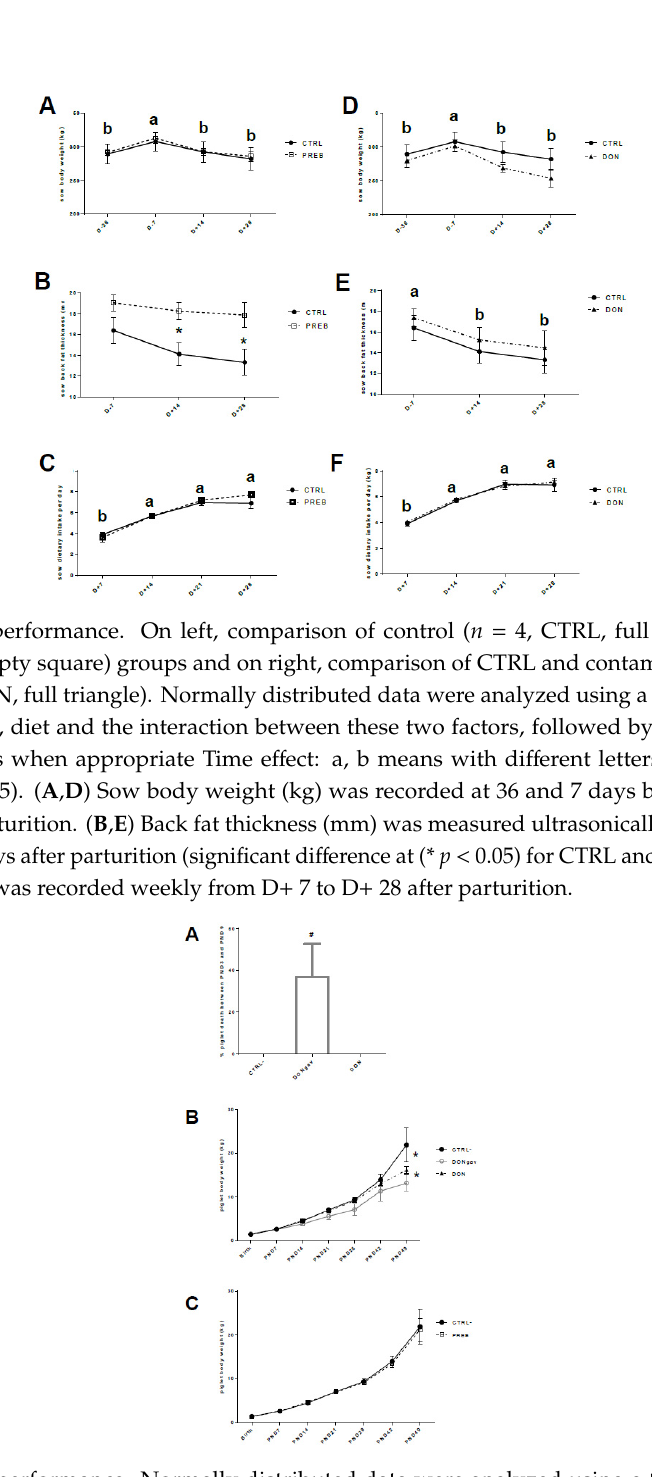
Figure 3. Piglet performance. Normally distributed data were analyzed using a two-way ANOVA performing time, diet and the interaction between these two factors, followed by Tukey’s multiple comparison tests when appropriate ( A ) Piglet death proportion (% of the litter size) from PND3 to PND9 after force-fed gavage with DON (DONgav) compared to control (CTRL-) and maternal supplementation with DON (DON). # means di ff erence at p = 0.06 between DONgav and the two other groups (CTRL- and DON). ( B ) Piglet body weight (kg) from birth to PND49. Time, diet and the interaction time x diet were highly significant ( p < 0.0001). DONgav piglet body weights (empty grey circle) were lower than CTRL- (full black circle) and DON piglets (full black triangle) (* p < 0.0001). ( C ) Body weights of piglets CTRL- (full black circle) and PREB (empty black square) recorded from birth to PND49 were not di ff